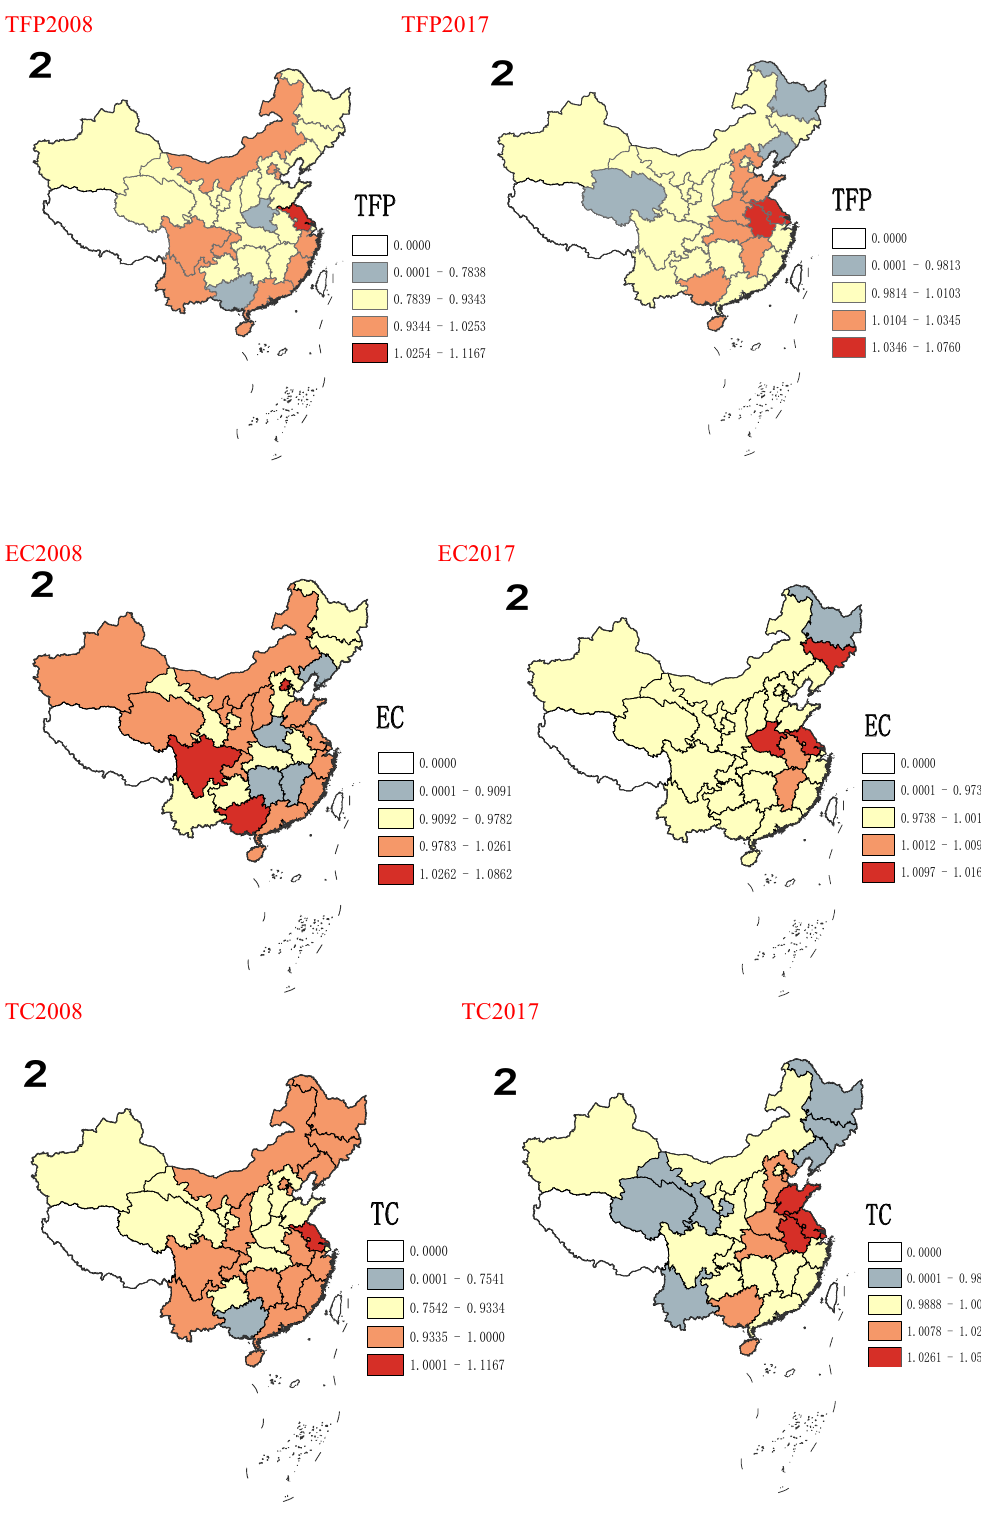
Figure 5. Spatial distribution of TFP, EC, TC. Source : ArcMap10.7 https:// deskt op. arcgis. com/ zh- cn/